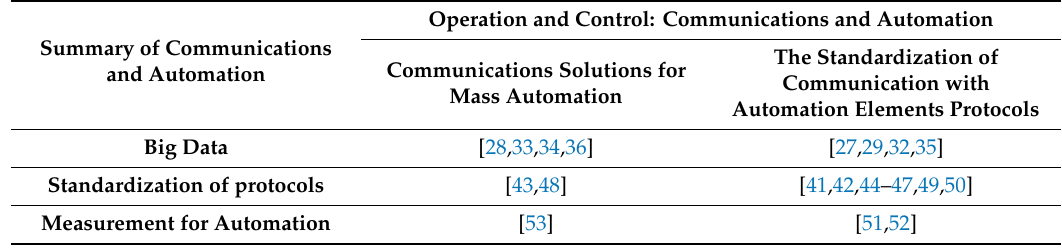
Table 2. Summary of Communications and